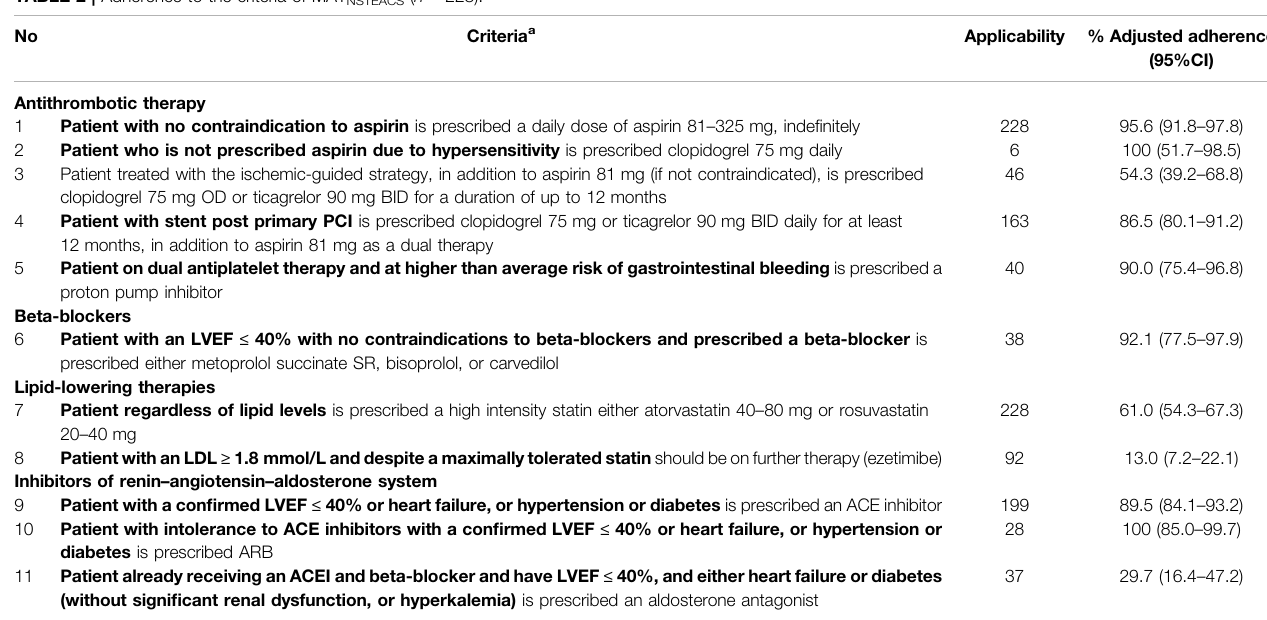
TABLE 2 | Adherence to the criteria of MAT NSTEACS ( n (cid:1)